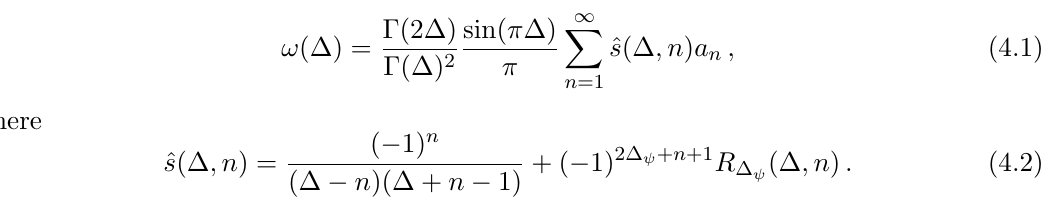
Figure 4 . The choice of integration contour leading to a well-de(cid:12)ned action of ! , equation (3.30). so that the oscillating factors in (3.25) and (3.27) are in phase. The action of the general functional (3.18) can then be written